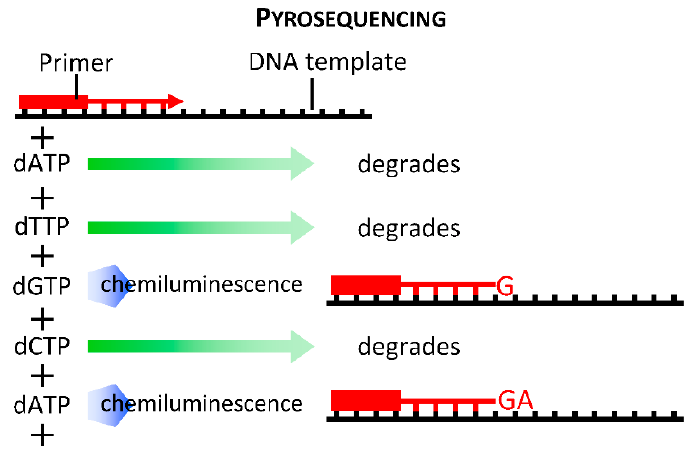
Figure 4. Principle of pyrosequencing.